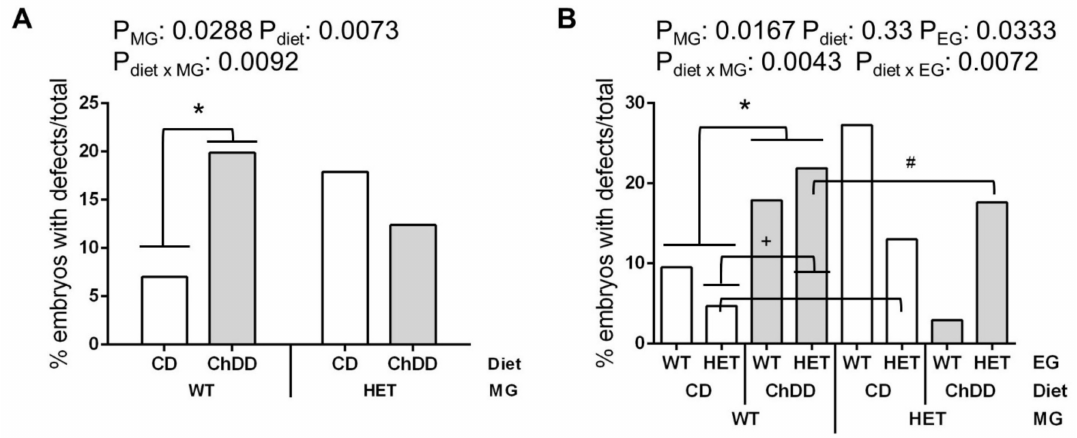
Figure 2. Effect of synthetase deficiency and low choline diet on incidence of defects at E10.5. Values are % embryos with defects/total embryos evaluated. n = 33–78 embryos from 16–18 litters per group, analysed by binary logistic regression including litter as a random effect, post hoc by mvt. ( A ) Maternal effects, with embryo genotypes grouped. * Significant increase in defects due to ChDD in the litters of WT mothers compared to CD WT mothers ( p = 0.0259). ( B ) Genotype and diet effects, including embryonic genotype. * Significantly increased in ChDD WT mothers as compared to CD WT mothers ( p = 0.0237). # Significantly increased in ChDD HET embryos as compared to CD HET ( p = 0.0350). + Significantly increased in ChDD HET embryos with WT mothers as compared to CD HET embryos with WT mothers ( p = 0.0030). White bars: CD, grey bars: